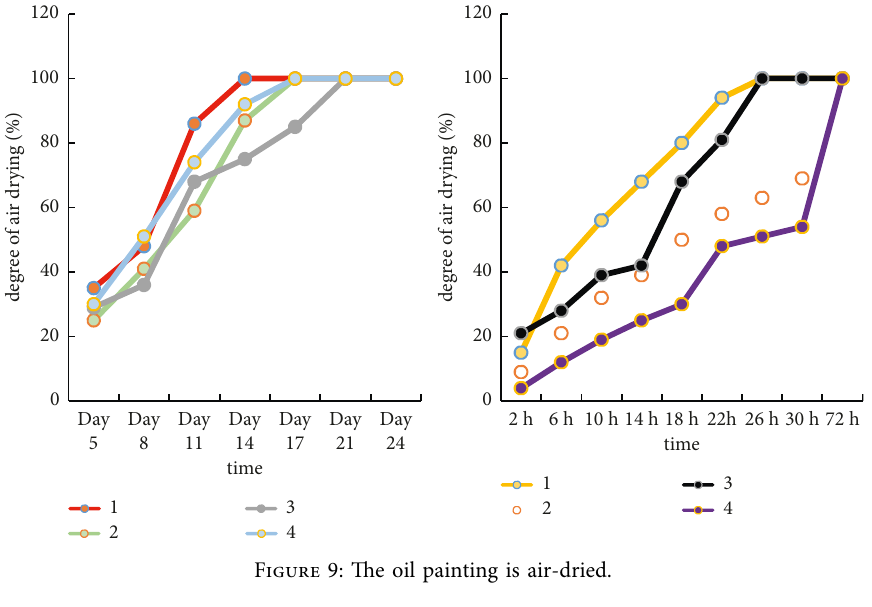
Figure 9: The oil painting is air-dried.